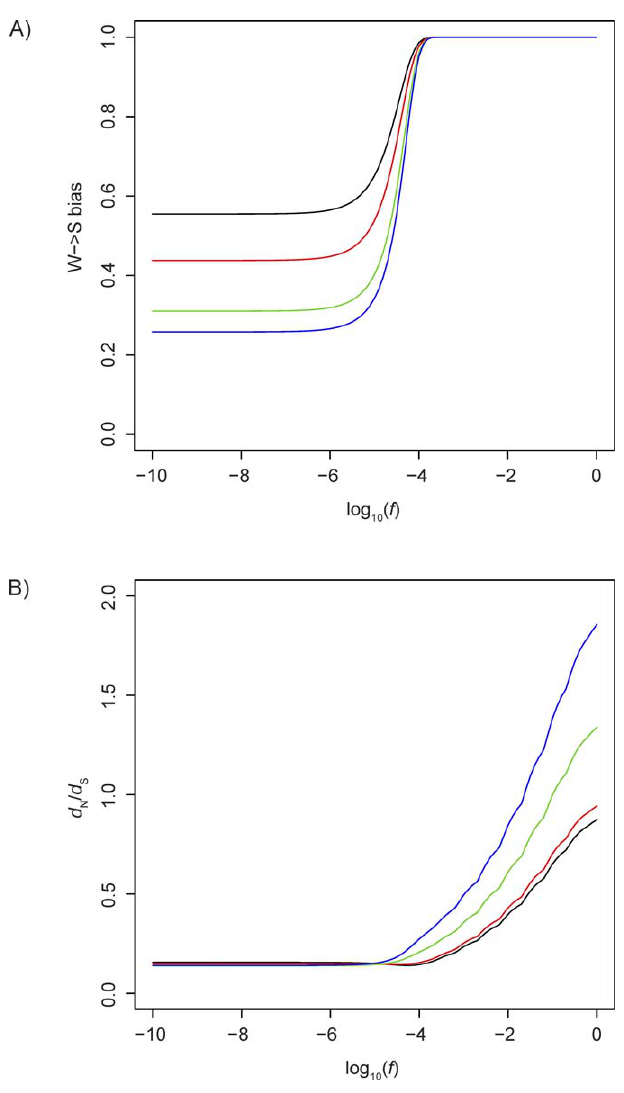
Figure 6. Predicted Effect of a Bias Towards Fixation of W ! S Mutations, Considered as a Selective Coefficient ( f ), on Coding Sequences under Purifying